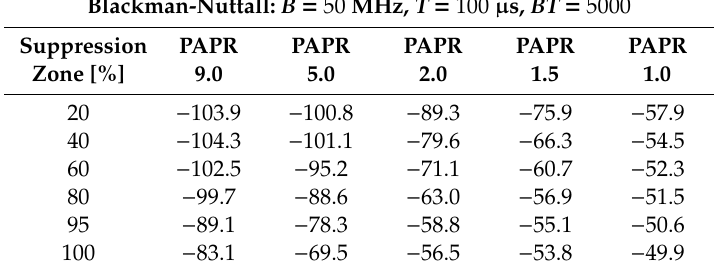
Table 4. Mean peak side lobe (PSL) (dB) on 100 trials using FMeth varying the PAPR and the percentage of the suppression zone. Noise waveforms with Blackman-Nuttall spectrum.